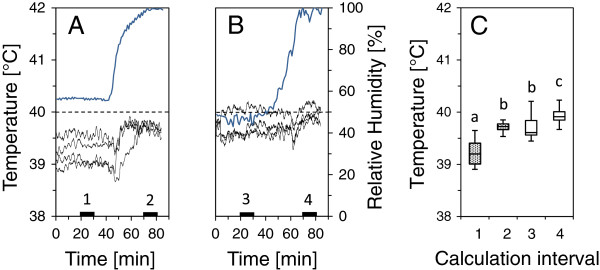
Effects of relative humidity on leaf temperature of R. ferrugineum inside of two heat exposure chambers. In the heat exposure chambers of the Heat Tolerance Testing System twigs were exposed to a sub - lethal air temperature (+40°C) that was held constant A. in darkness and B. under full solar irradiation. Thin lines: leaf temperatures, bold lines: relative humidity, dashed lines: air temperature, solid rectangles: calculation periods for statistical comparisons. At high humidity (Rh > 90%) leaf temperatures moved markedly closer to air temperature due to a strongly reduced transpiration. C. Box plots of the mean leaf temperature as a function of each calculation period. Boxes: median, upper and lower quartile. Whiskers: maximum, minimum. Dotted boxes: in darkness (data from A.), white boxes: at full sunlight (data from B.). At high humidity (2, 4) mean leaf temperatures had significantly (P < 0.01) increased due to the restricted leaf transpiration, while leaf temperature variability was clearly reduced.